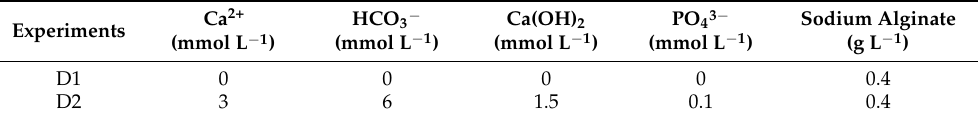
Table 4. Effect of organic compounds on